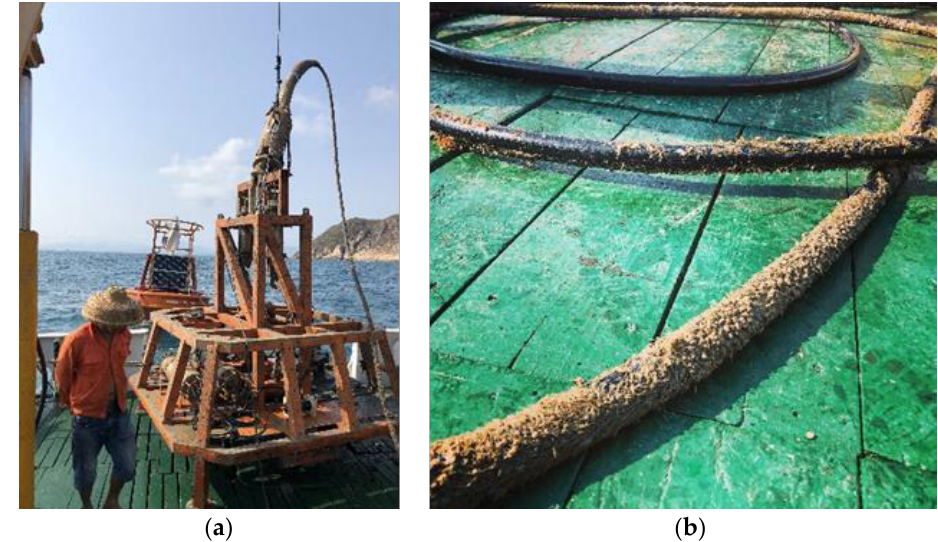
Figure 24. Recovery of the Benthic Node and EOM cable: ( a ) Benthic Node recovered on the ship deck; and ( b ) appearance of recovered EOM cable.